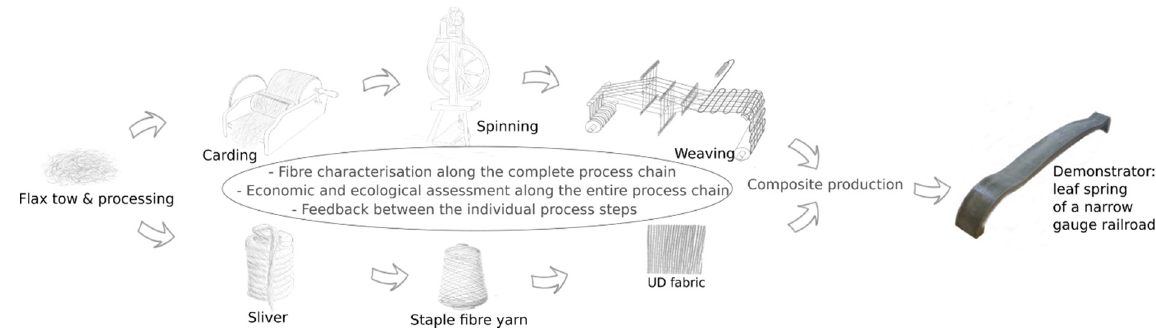
Figure 1. Process chain—from raw fibre to composite.